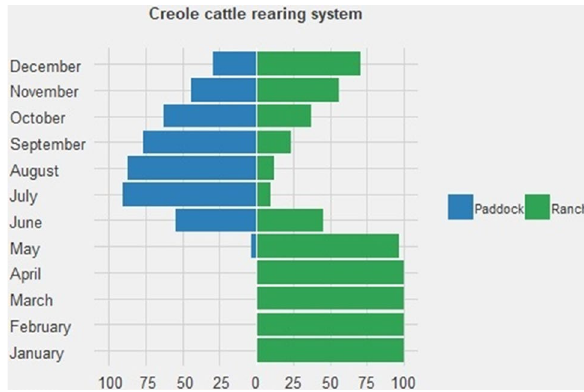
Fig. 2 Percentage of Creole cattle located in paddocks or on rangelands around Pasorapa, Bolivia, in